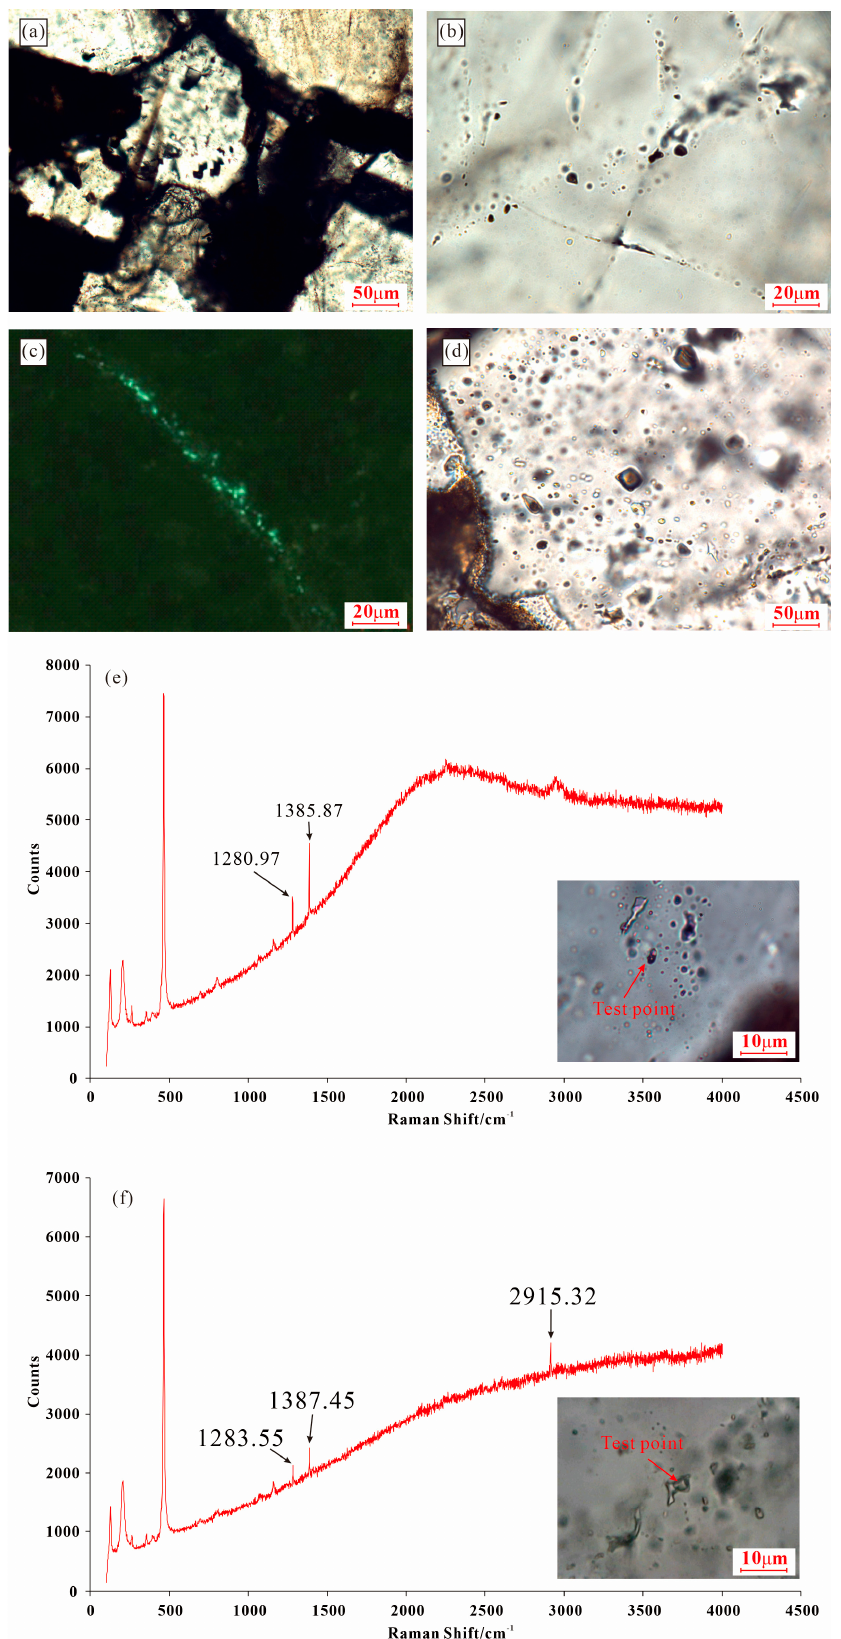
Figure 9. Photomicrographs and laser Raman spectrum of representative hydrocarbon inclusions from the Lower Shihezi Formation tight sandstones in the Duguijiahan block, Ordos Basin: ( a ) well